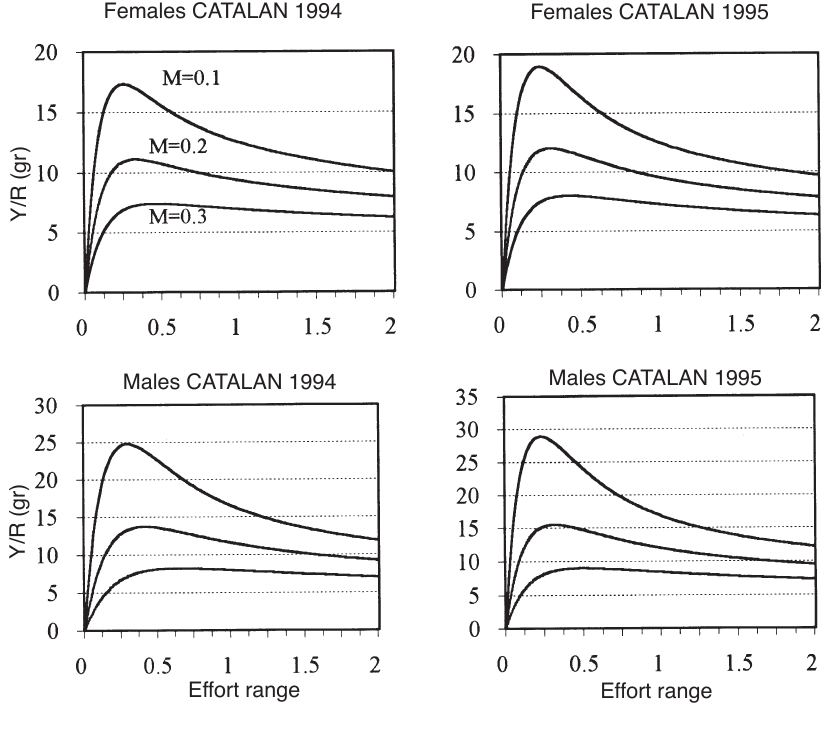
F IG . 2. – Catalan yield per recruit curves.